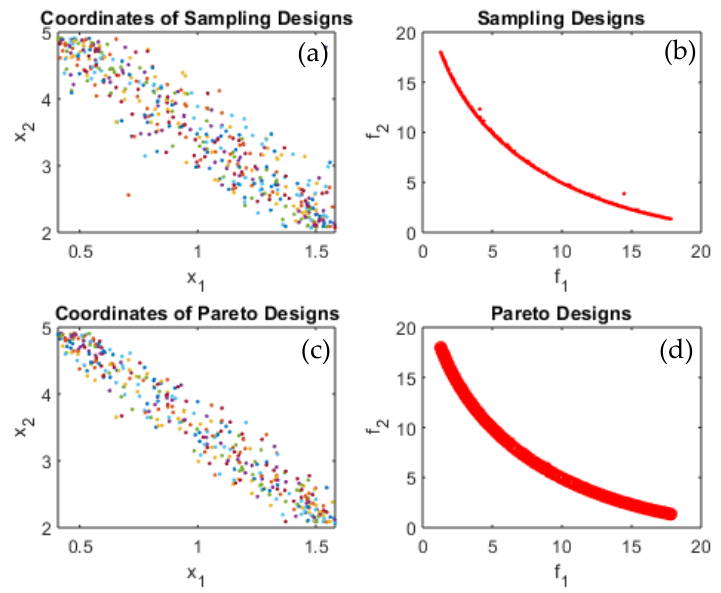
Figure 6. Computational simulations Pareto frontier determination of test function T1 ( a ) coordinates od sampling points; ( b ) sampling points in feasible design space; ( c ) coordinates of Pareto points; ( d ) the seeking Pareto frontier.